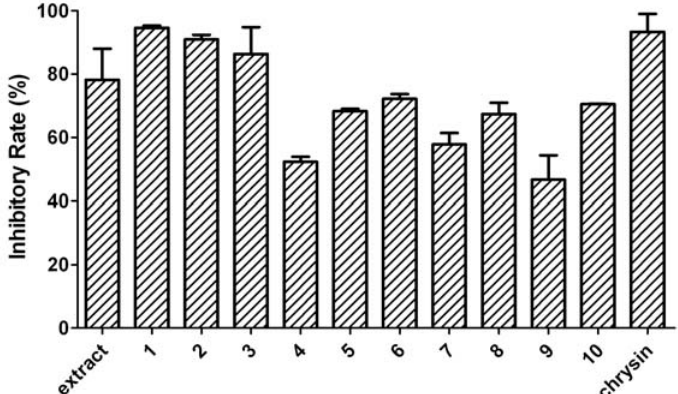
Figure 3. Aromatase inhibitory rates of the dichloromethane extract of A. macrocephala , compounds 1 - 10 and